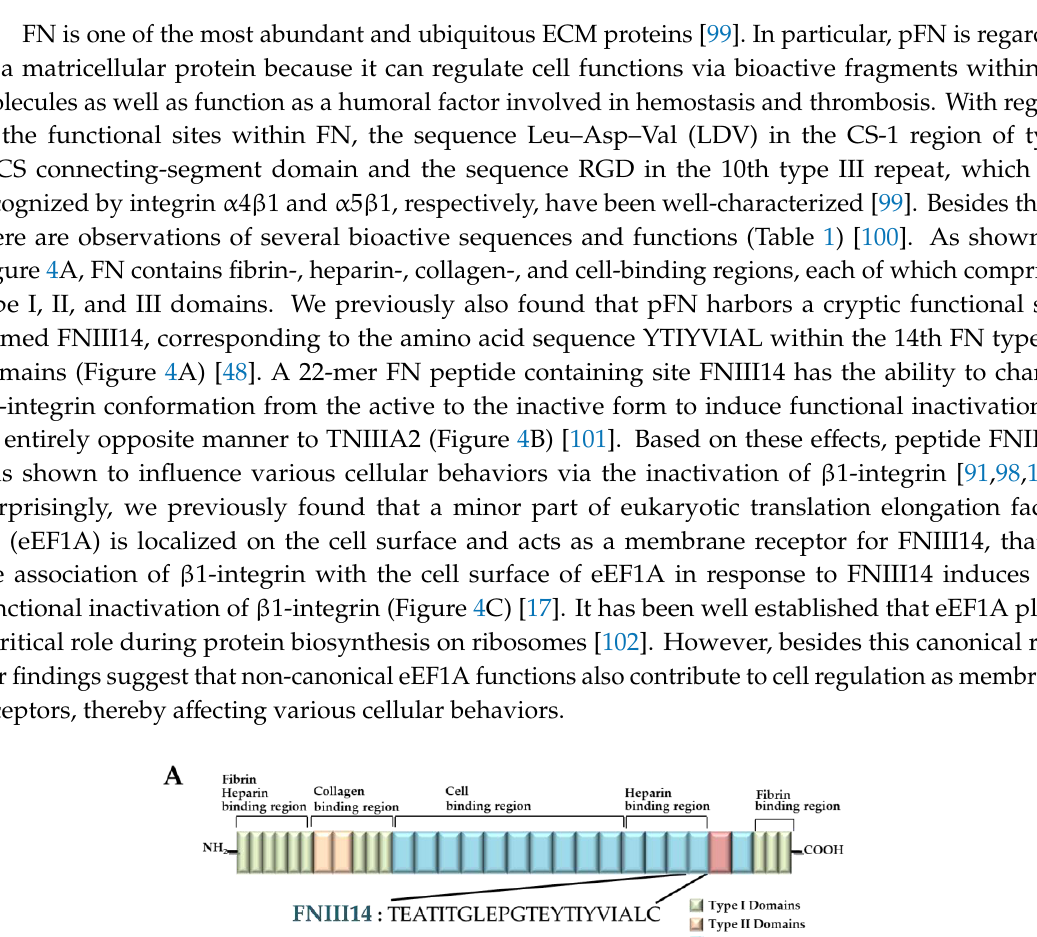
Table 2. Antitumor effects of peptide FNIII14 under in vitro and in vivo settings. Cancer Type